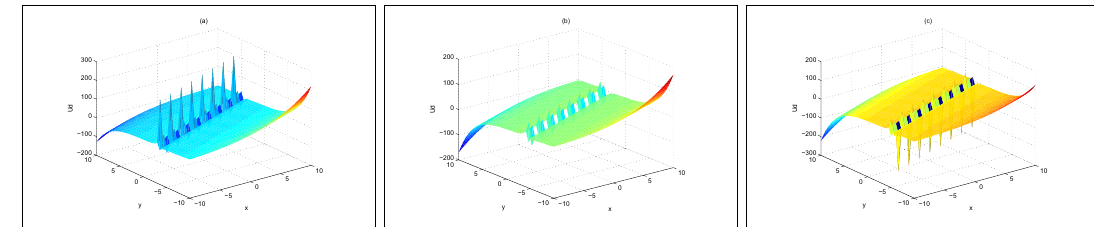
Figure 3: The solution of the ( 2 + 1 )- dimensional gCBS equation corresponding to ( ) U z s 2 , ( a ) = t −3 , ( b ) = t 0 and ( c ) = t 3 .